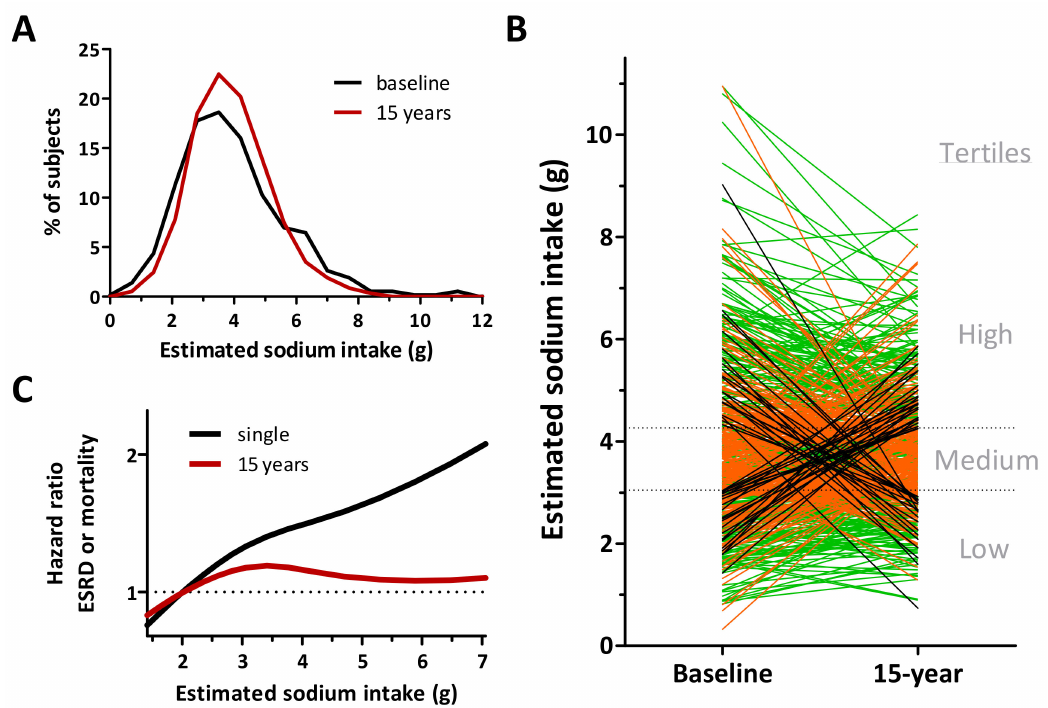
Figure 2. Single versus multiple 24-h collections. We estimated sodium intake with a single baseline collection and averaged collections during 15-year follow-up. ( A ) Population sodium intake was similar when estimated at baseline or during the 15-year follow-up. ( B ) However, individual level estimates of sodium intake were substantially di ff erent when multiple measurements were taken into account. Only 50% of the subjects remained in the similar sodium intake tertile (green lines), while 42% moved to the adjacent tertile (orange lines) and 8% of the subjects switched between the outer tertiles (black lines). ( C ) When investigating the association between long-term renal outcome and sodium intake, hazard ratios changed significantly when baseline sodium intake estimates were used instead of 15-year estimates. Adjusted from